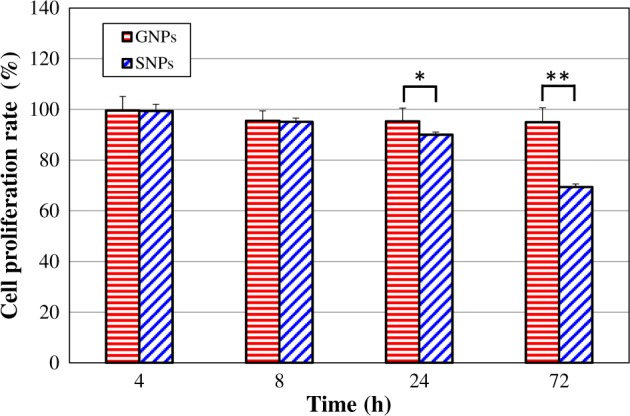
Cell proliferation rates of HDFs treated with GNPs/SNPs for 4, 8, 24 and 72 h. The results are presented as the mean ± SD (n = 6). *P < 0.05, **P < 0.01. A cytotoxicity grade of 0 indicates P ∈ [81%, 100%], grade 1 indicates P ∈ [61%, 80%], grade 2 indicates P ∈ [41%, 60%], grade 3 indicates P ∈ [21%, 40%] and grade 4 indicates P ∈ [0, 20%]